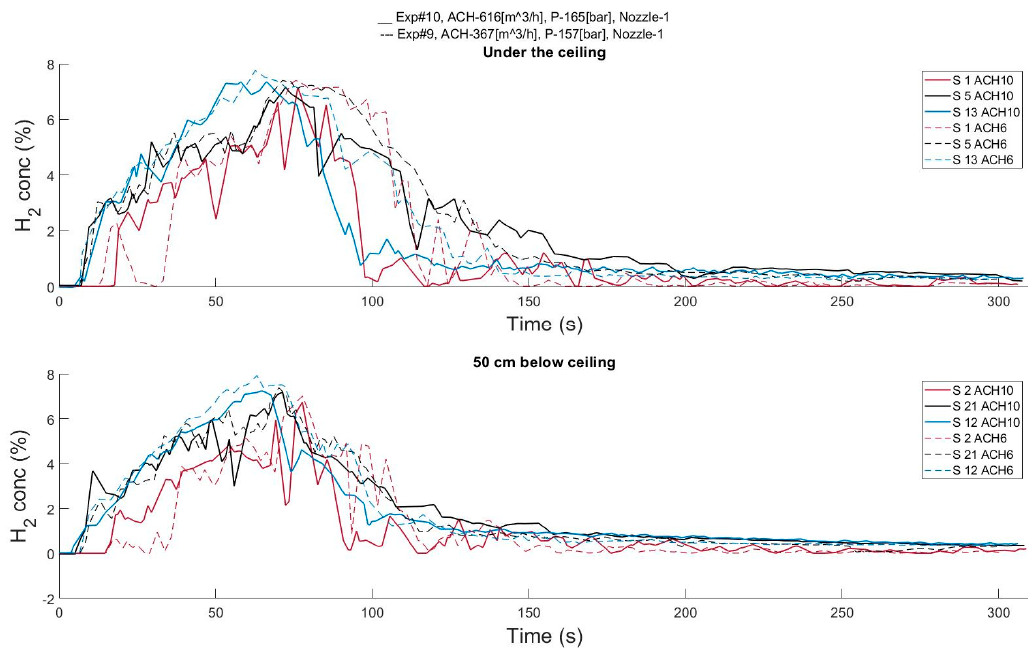
Figure 6. Concentration in the cloud and its propagation from hydrogen releases with 10 ACH and 6 ACH.